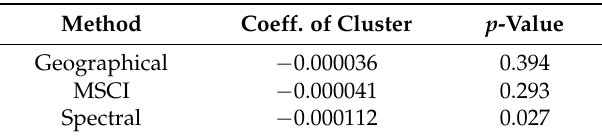
Table 2. Regression statistics.